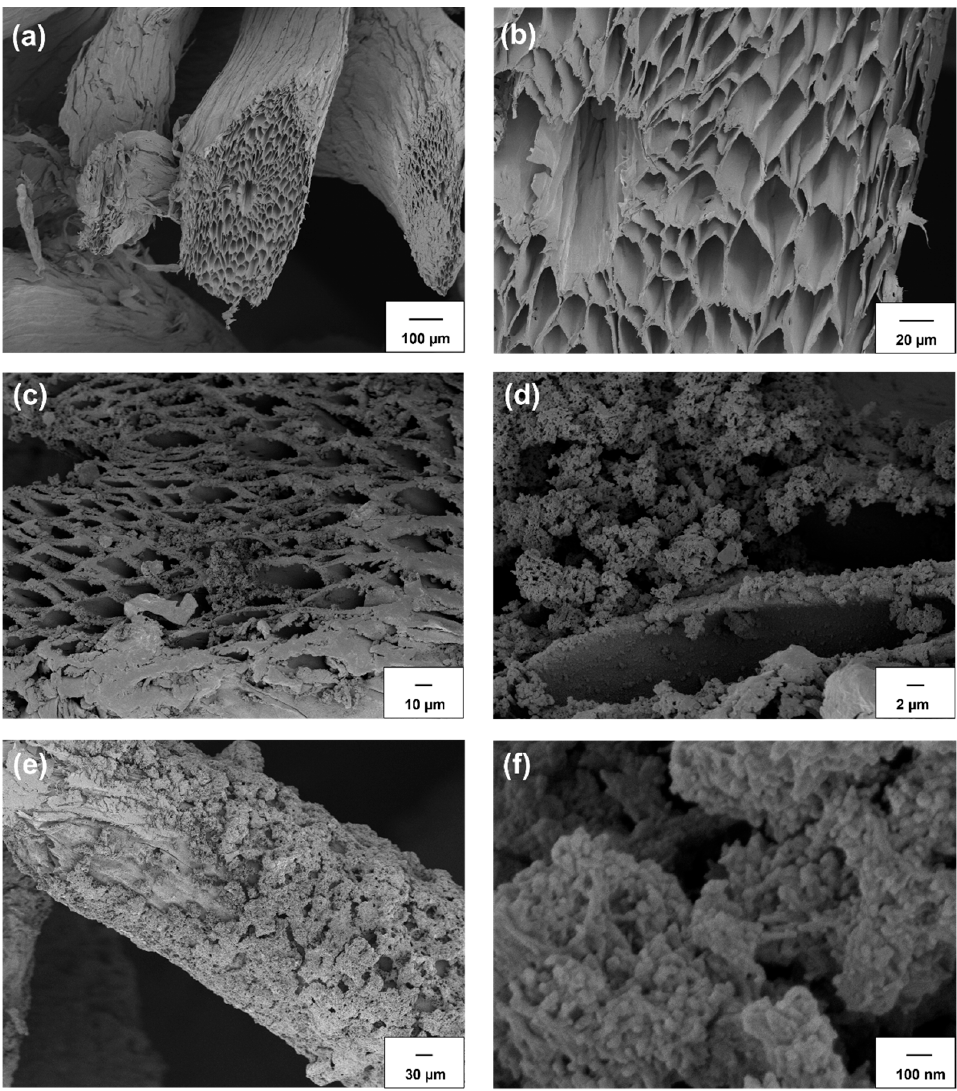
Figure 3. SEM images of LS ( a , b ) and P-LS ( c – f ). As expected, LS is characterized by a hollow three-dimensional network structure guaranteeing excellent structural stability and high porosity (Figure 3 a,b). Figure 3 c,f shows the PANI discontinuous growth on the surface of LS in form of mixed rod-like and globular-like aggregates, increasing the roughness of the LS surface. In more detail, the rods were, on average, 150 nm long and 30 nm wide. In addition, N 2 adsorp- tion/desorption isotherms at − 196 °C were also collected for both LS and P-LS samples. Figure S1 reports the obtained isotherms in the case of the LS sample. In general, ac- cording to the literature [46], a very low value of specific surface area for LS was found ( ca. 0.15 m 2 ·g − 1 ). The collected isotherms (Figure S1) are typical of non-porous materials [47] and no hysteresis was detected. When PANI was introduced on LS, no variation in the surface area value was detected due to the very low amount of the polymer on the surface of the sponge ( ca. 6.5 wt.%). Therefore, if on one hand these results justify the low adsorption capacity of the materials compared to other systems, on the other hand, they demonstrate the role of the surface interaction on the selective removal of the pollutants in solution.